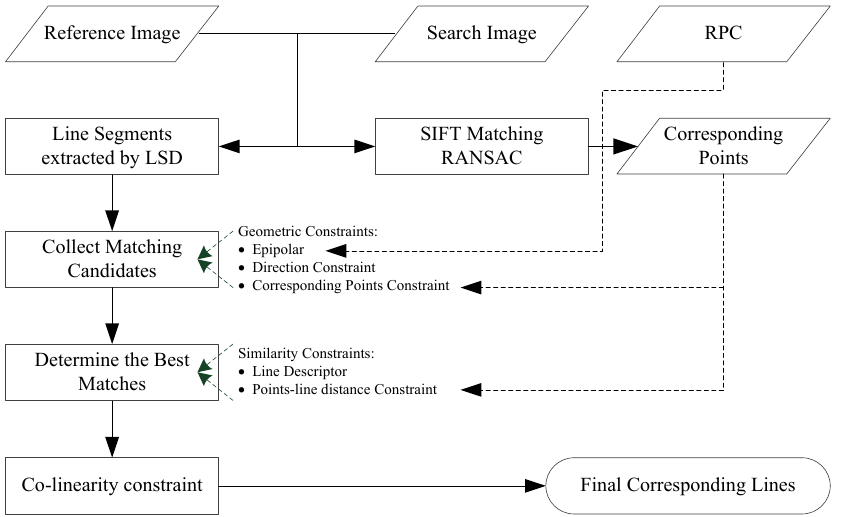
Figure 1. Flowchart of proposed line matching approach.